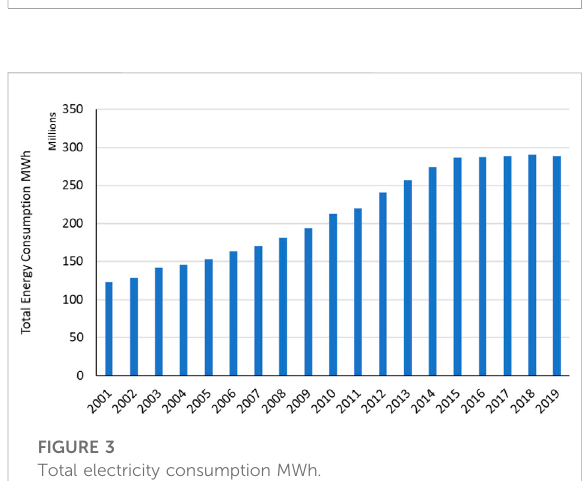
FIGURE 3 Total electricity consumption MWh.